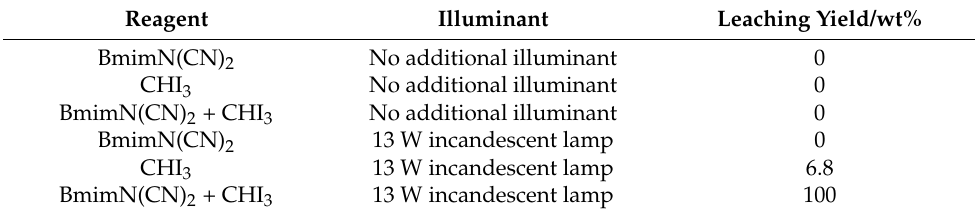
Table 1. Gold leaching yield with different reagents and conditions.